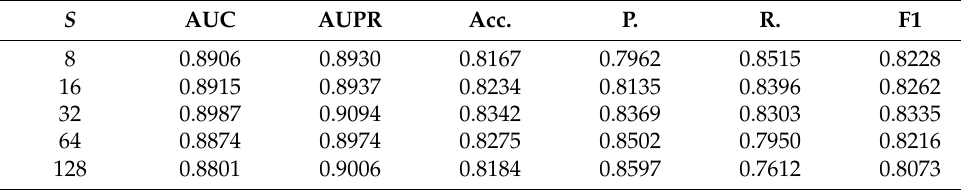
Table 3. Prediction results of LRGCPND with different embedding size S